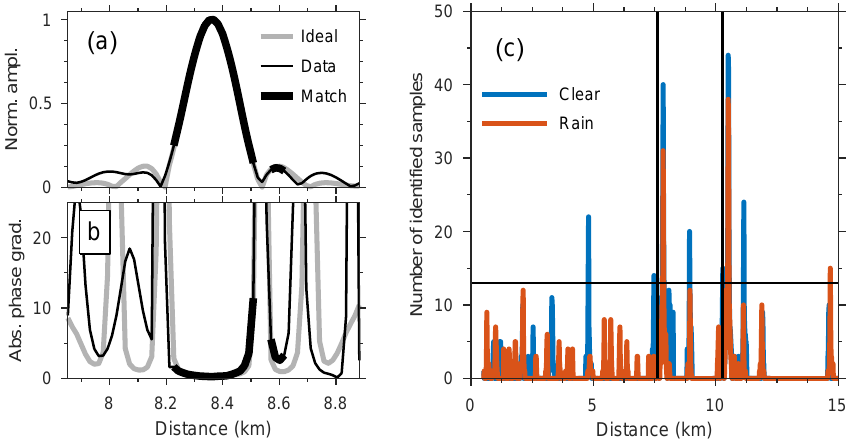
Figure 8. Matching data points from a single radar pulse to the ideal point target signature. Panel (a) shows normalised amplitude data, the corresponding ideal point target signature and matching data points in the vicinity of a wind turbine. Panel (b) shows the absolute phase gradient, the corresponding ideal point target signature and matching data points. Panel (c) shows the number of matching data points when shifting the ideal point target signature along data from a single radar pulse during two occasions: one during clear weather, the other during precipitation. Vertical lines show the location of two wind turbines, and the horizontal line shows the minimum number of data points used in this work to identify a point